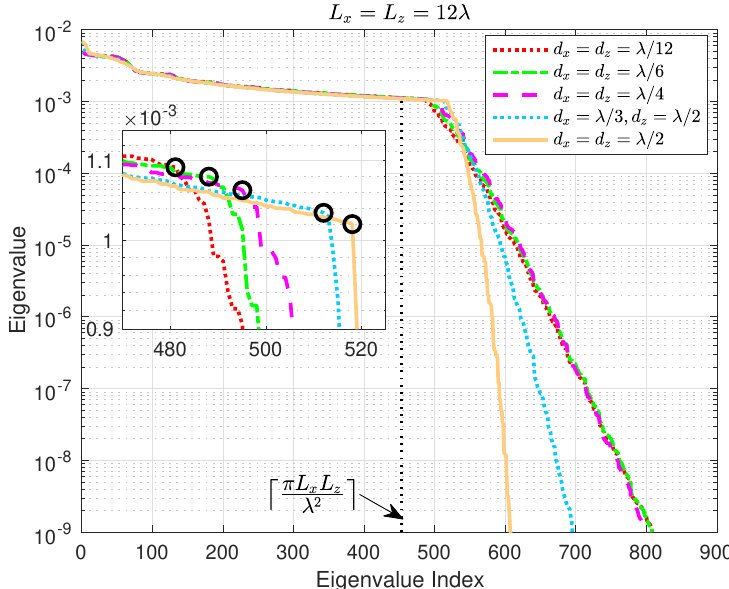
Figure 3. Eigenvalue versus eigenvalue index of R 0 / N in non-increasing order for various element spacing d x and d z with L x = L z = 12 λ . In addition, the asymptotic spatial degrees of freedom (DoF) (cid:100) π L x L z (cid:101) derived in [48] are depicted for min ( L x , L z ) / λ → ∞ . Note that both the eigenvalue and λ 2 its index are dimensionless. Each dark circle in the inset represents the inflection point where the eigenvalues start to drop